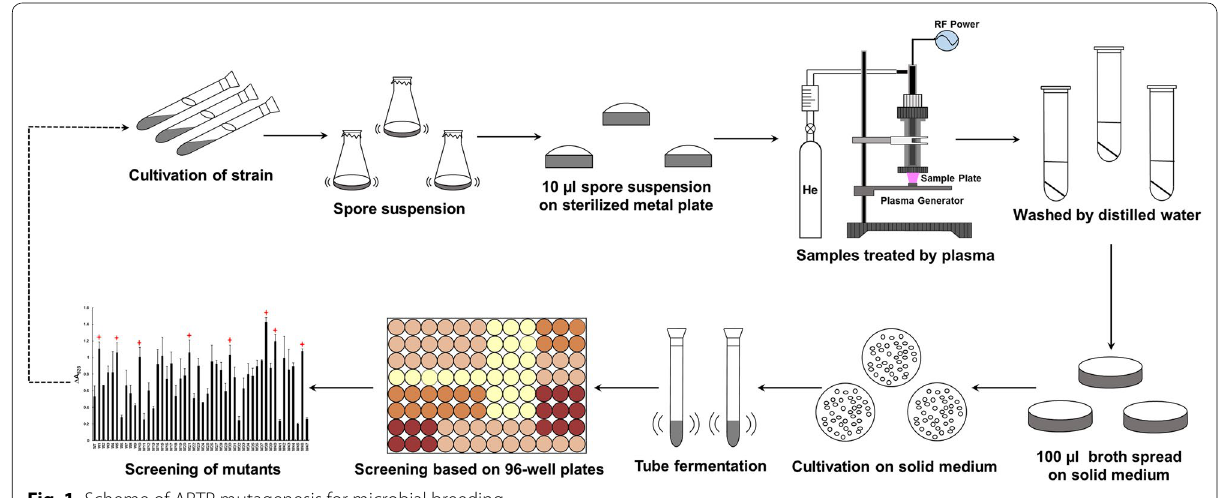
Fig. 1 Scheme of ARTP mutagenesis for microbial